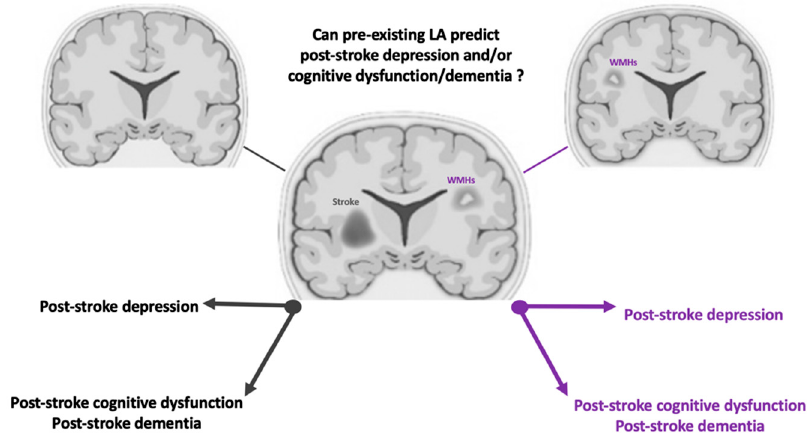
Figure 2. Graphical representation/summary of the aim of the review.